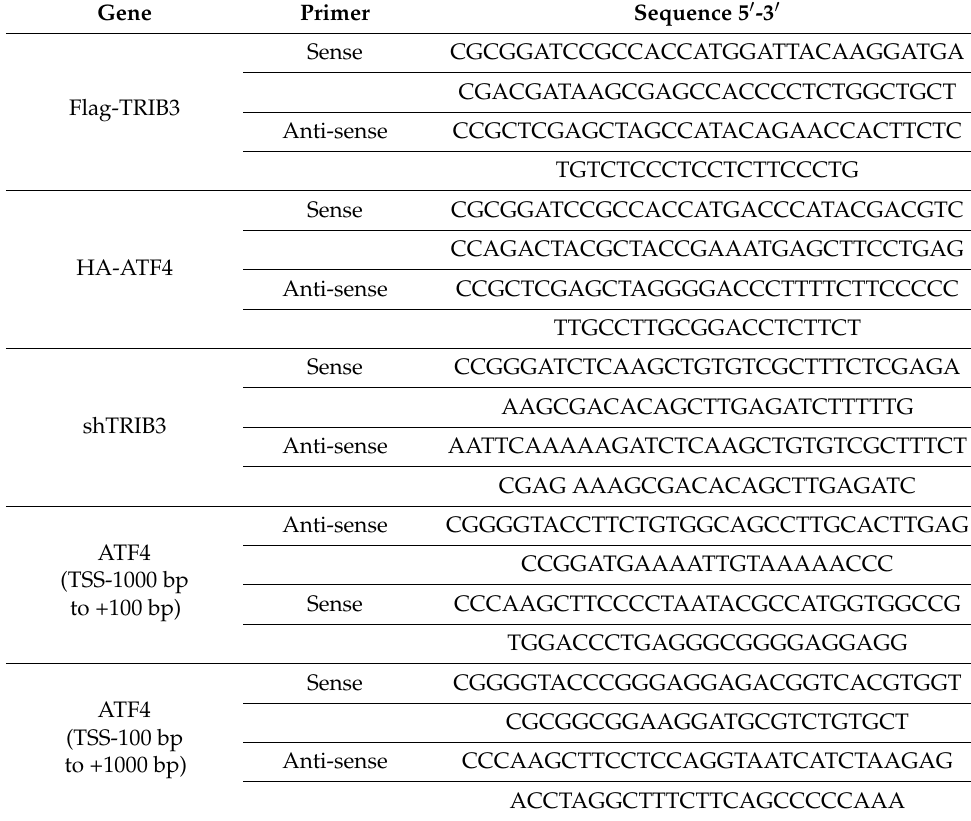
Table 1. Primers used in the